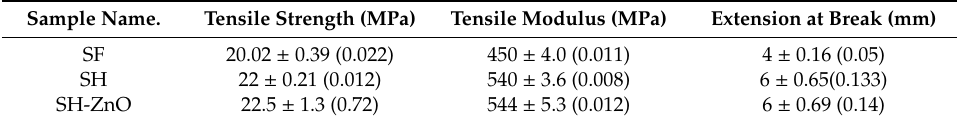
Table 2. Mechanical properties of di ff erent dressing samples.